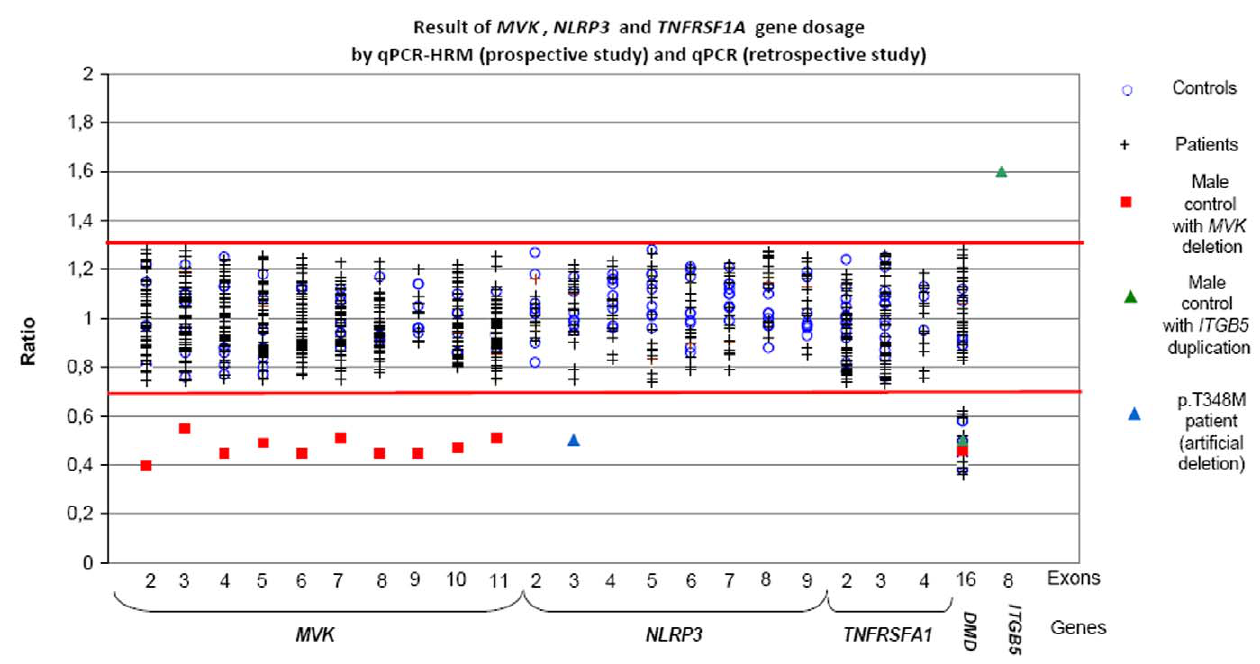
Figure 2. Results of MVK , NLRP3 and TNFRSF1A gene dosage analysis by qPCR-HRM (prospective study) and qPCR (retrospective study). We screened by qPCR-HRM (i) exons 2–8 and 10–11 of the MVK gene in 10 controls, 1 DNA sample with a 12q23.2 deletion, and 49 patients, (ii) the exon 3 of the NLRP3 gene in 9 controls, 10 patients, and the artificial positive p.T348M patient and (iii) exons 2–4 of the TNFRSF1A gene in 13 controls and 54 patients. We screened by qPCR (i) exon 9 of the MVK gene in 10 controls, 1 DNA sample with a 12q23.2q24.11 deletion, and 12 patients and (ii) exons 2–9 of the NLRP3 gene in 9 controls and 38 patients. target exon concentration = reference exon concentration ½ R ~ target exon concentration = reference exon concentration ½